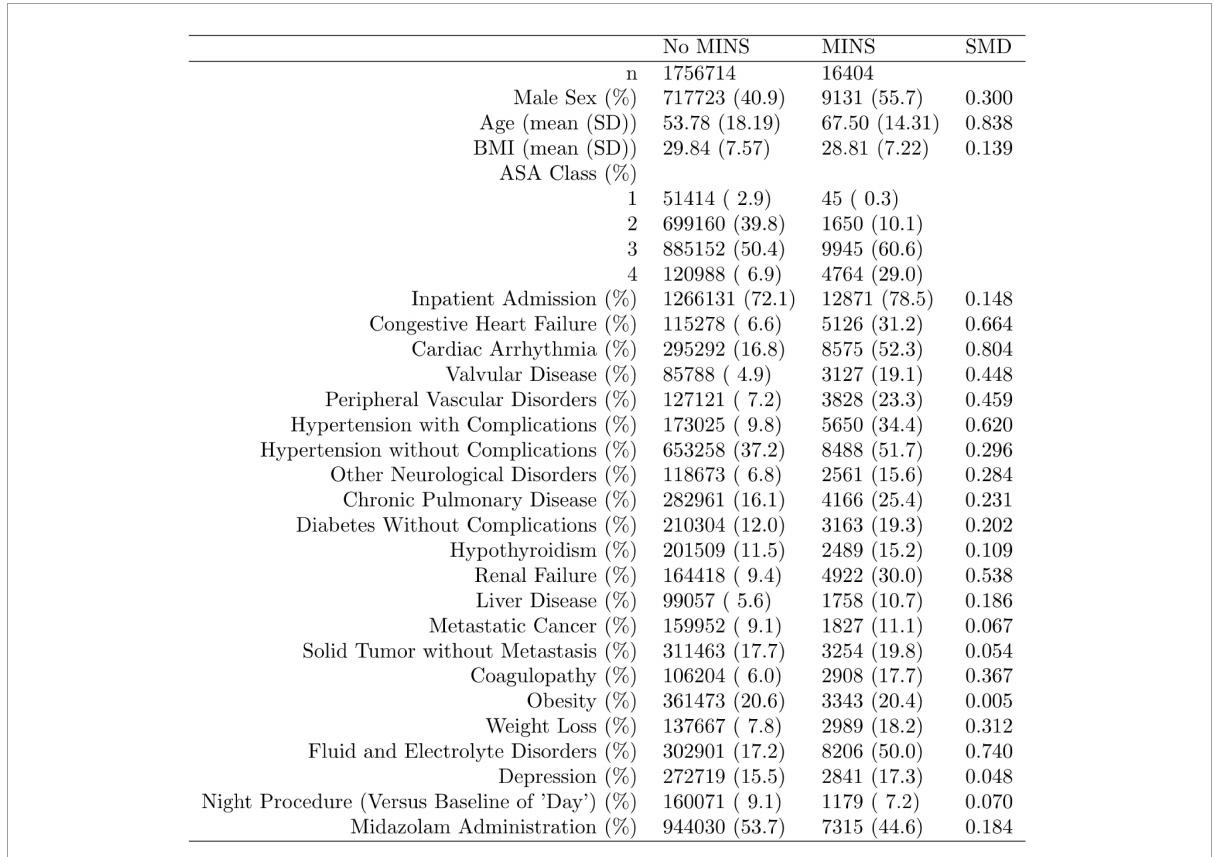
FIGURE1 Distribution of the propensity score stratified by whether subjects had perioperative myocardial injury in non-cardiac surgery (MINS). Standardized mean difference (SMD) column represents the standardized mean difference.